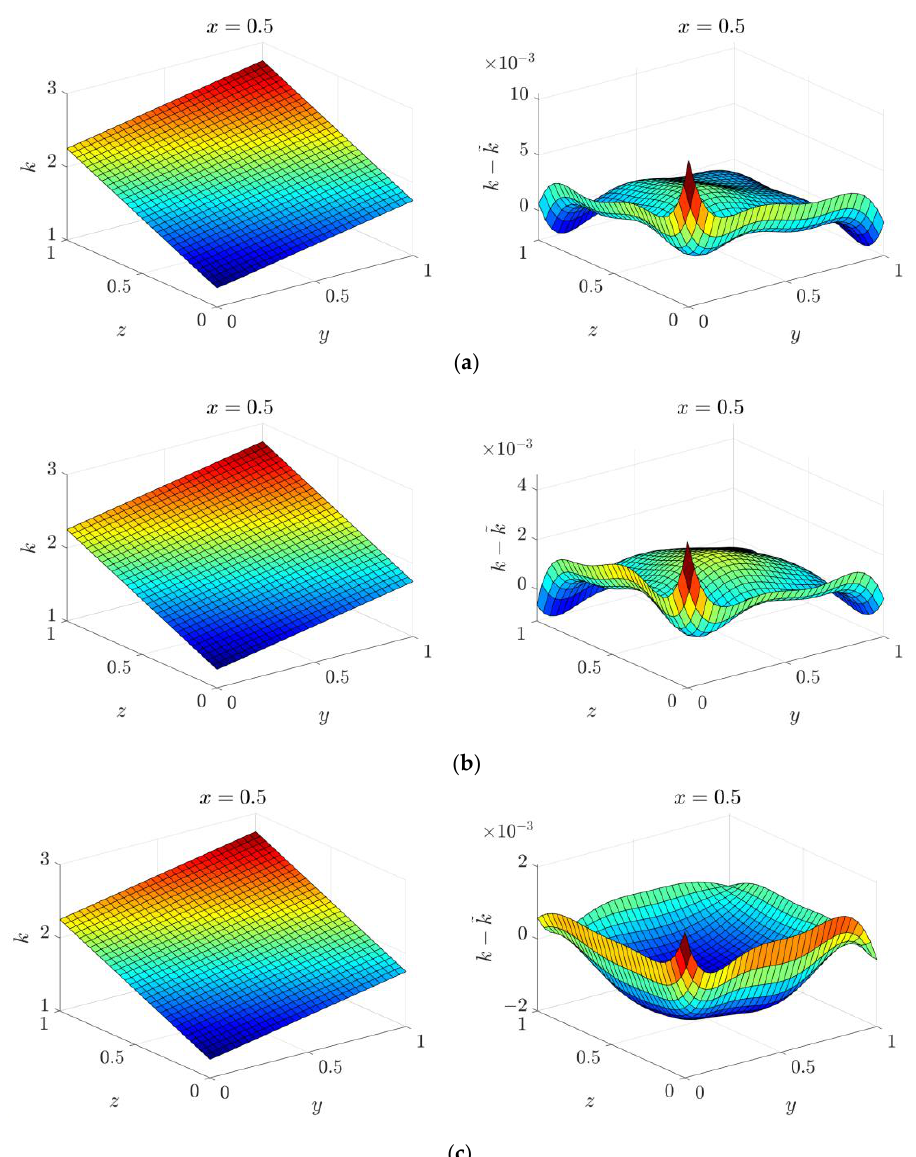
Figure 22. Solution of wave number k for the 3D parameter identification problem in cubic domain under different discretizations: ( a ) N s = 7 × 7 × 7; ( b ) N s = 9 × 9 × 9; ( c ) N s = 11 × 11 ×